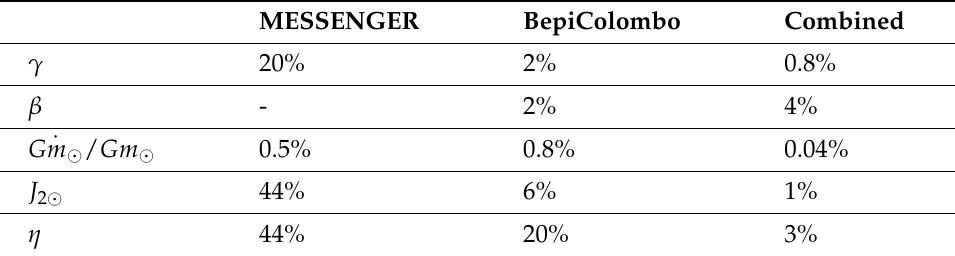
Table 5. Amplitudes ( A J taken relative to J 2 (cid:12) ) at which the true to formal error ratios exceed 3 in 2 (cid:12) the linear regions in Figure 4. For parameter β using only MESSENGER data, the true-to-false error ratio never exceeds 3 for the implemented amplitudes and the linear region does not